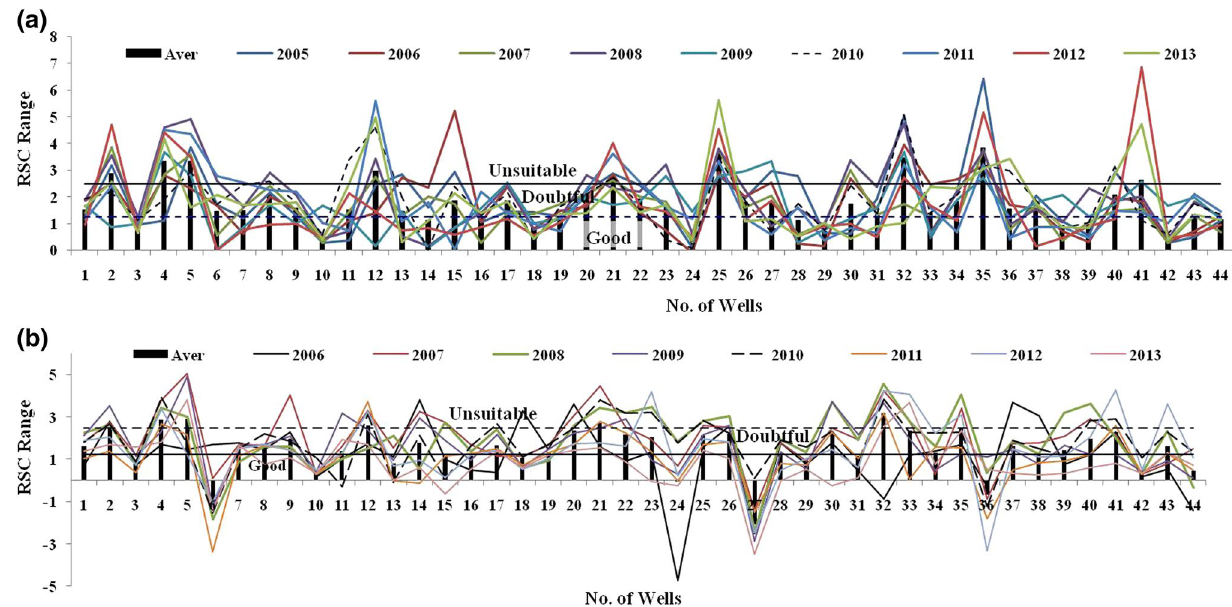
Fig. 3 a Nine-year (2005–2013) temporal representation RSC value during pre-monsoon. b Nine-year (2006–2013) temporal representation RSC value during post-monsoon